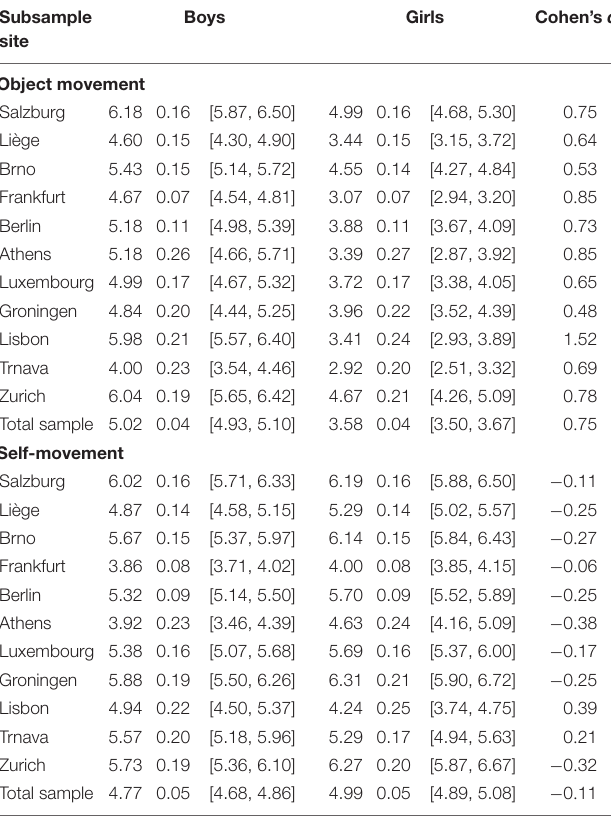
TABLE 3 | Marginal estimates of basic motor competencies (mean, SE , 95% CI ) per competence area and sex, stratified by subsample site and including Cohen’s d for effect size of differences between boys and